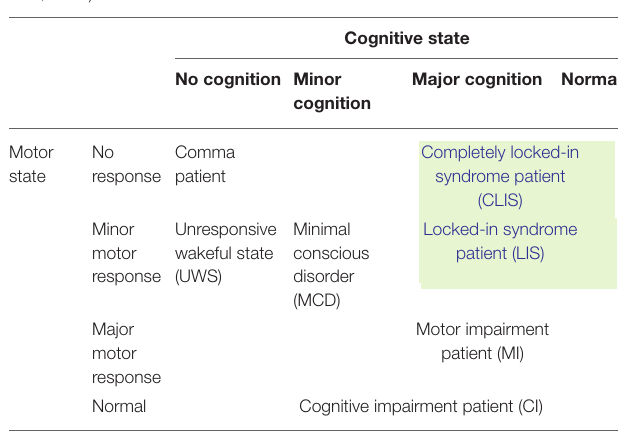
TABLE 1 | Categories of patients based on motor and cognitive states (Guger et al, 2017